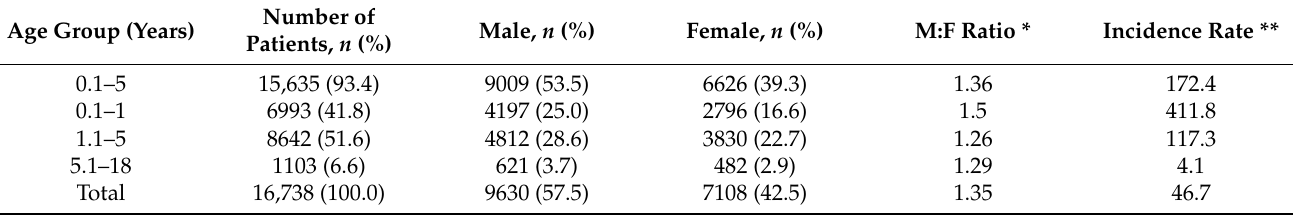
Table 2. Characteristics of patients under 18 years of age.